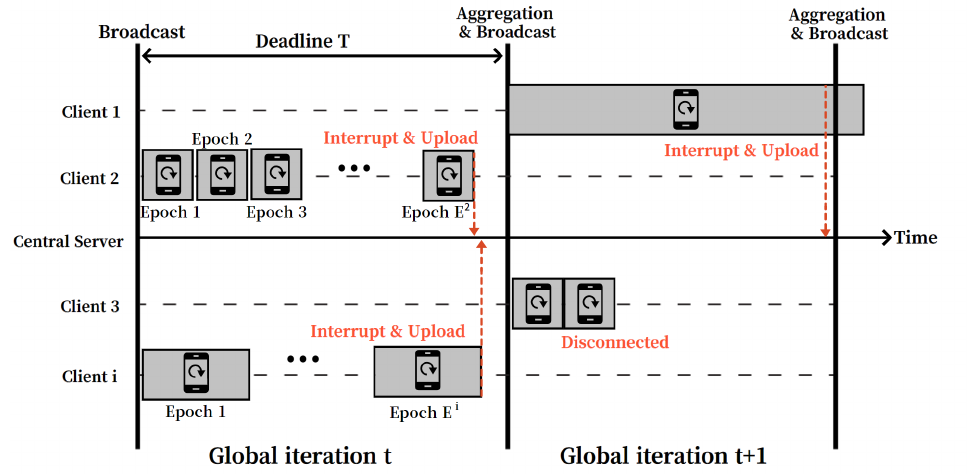
Figure 3. Examples of the diverse client training cases.